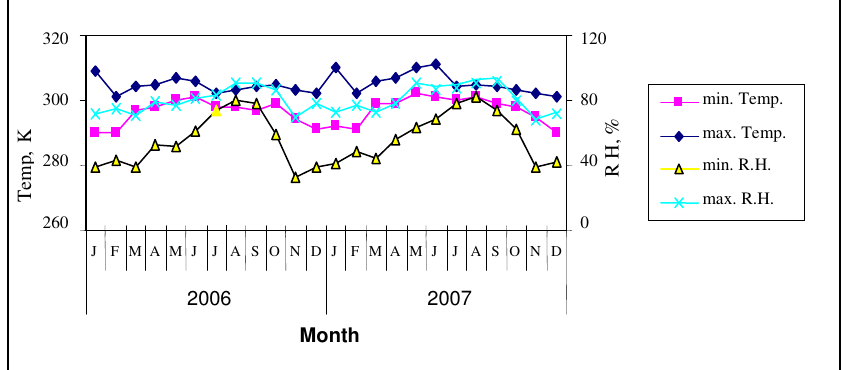
Figure 1 . Minimum and maximum temperature and relative humidity at marine